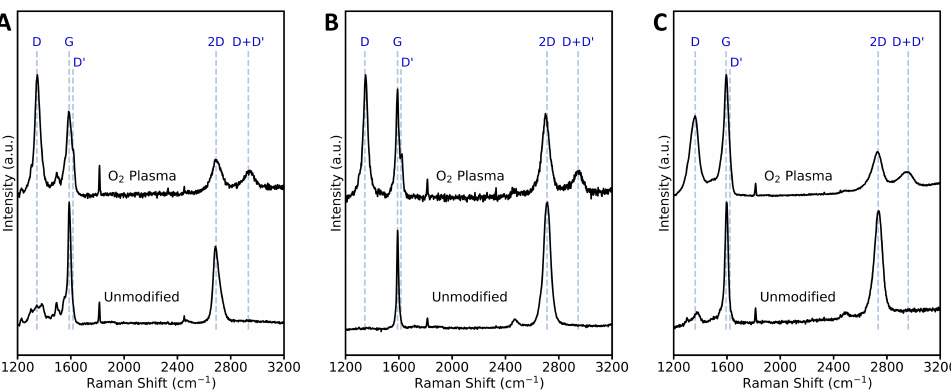
Figure 3. Average Raman spectra over 20 x 20 µ m 2 mapped areas before and after exposure to oxygen plasma for ( A ) monolayer, ( B ) hydrogen-intercalated QFS bilayer, and ( C ) multilayer EG. The spectra of the SiC substrate is